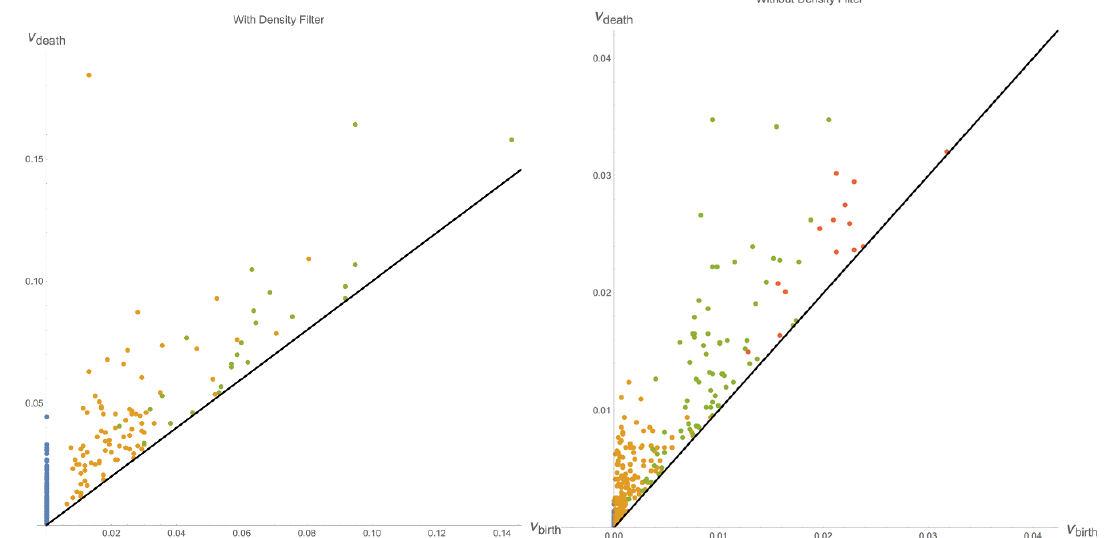
Figure 10 . Left: persistence diagram for lazy witness complex with 200 landmark points and density (cid:12)lter applied. In blue are 0-cycles, in orange 1-cycles, and in green 2-cycles. There is a long-lived 1-cycle corresponding to the excised cluster. Right: without the density (cid:12)lter, there is no long-lived 1-cycle. We observe a few 3-cycles (red), but, like the rest of the features, they are